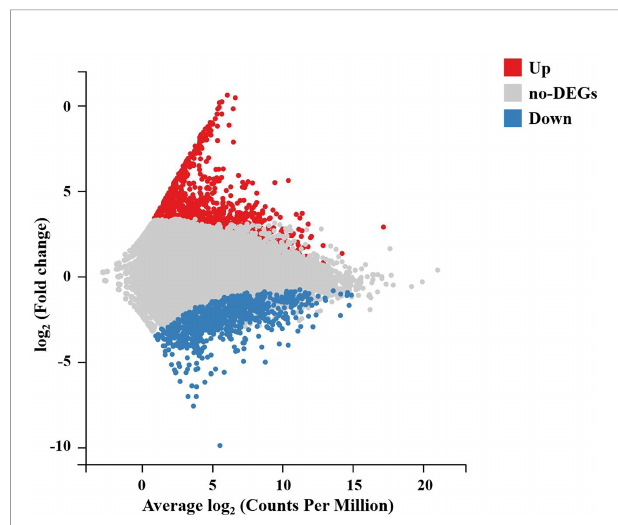
FIGURE 3 | M-versus-A plot (MA plot) between DEGs of the DIV1-infected and negative control Marsupenaeus japonicus intestines. The x-axis indicates the average expression level, and the y-axis indicates the fold change. Red dots represent the signi fi cantly upregulated DEGs, while blue dots represent the signi fi cantly downregulated DEGs ( Q -value < 0.05 and |log 2 (fold change)| > 1). Gray dots represent the DEGs that were not signi fi cantly different. DEGs, differentially expressed genes; DIV1, decapod iridescent virus